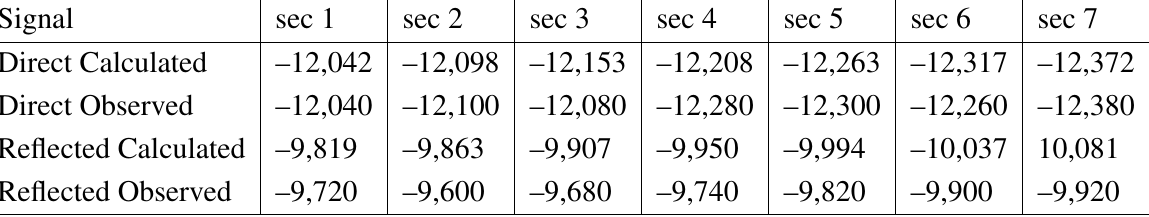
Table 2. Values of the predicted and detected Doppler frequencies for the February 4th 2005 ice